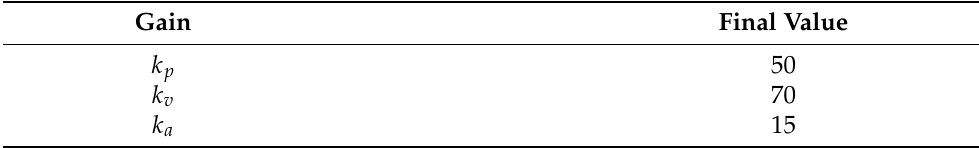
Table 3. Final values of the controller gains.